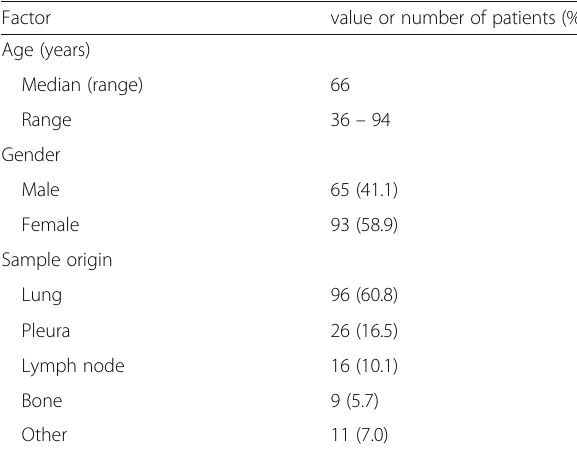
Table 1 Characteristics of patients with lung adenocarcinoma